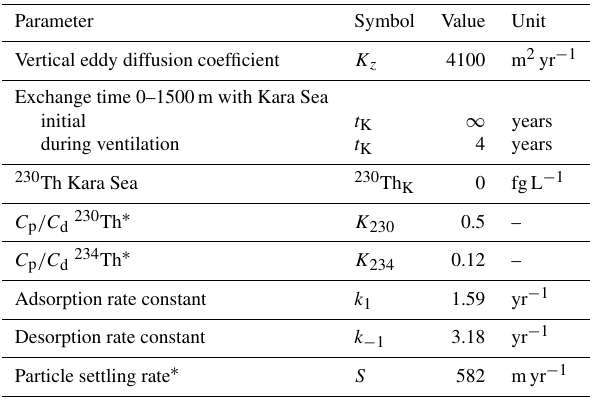
Table 1. Parameters of the profile model adapted from Rutgers van der Loeff et al. (2018), representing transient 230 Th in the Amund- sen